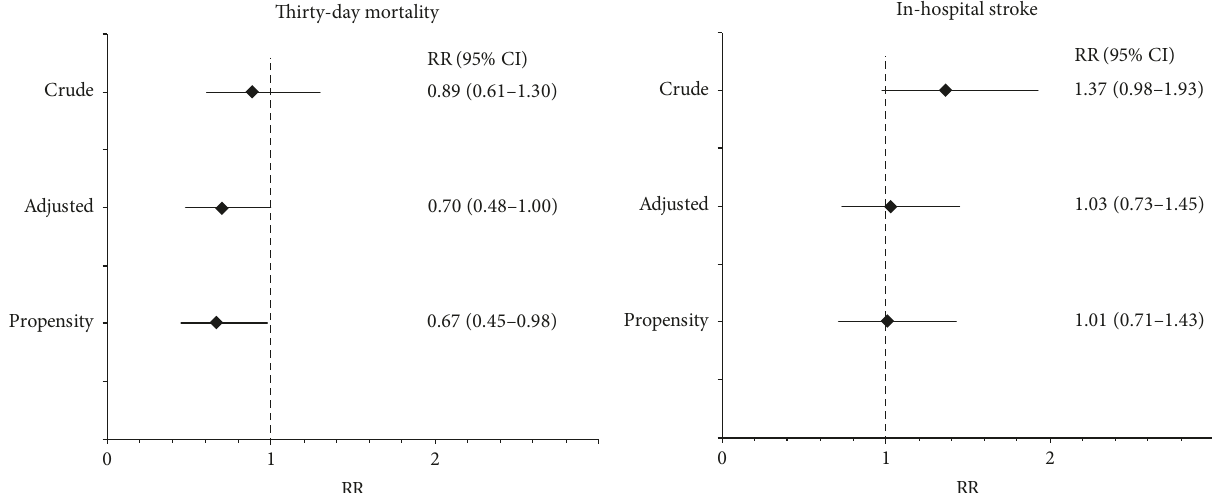
Figure 3: Crude, multivariable-adjusted and propensity-score adjusted relative risk of 30-day mortality and in-hospital stroke in patients with preoperative modified TEE screening compared to those without modified